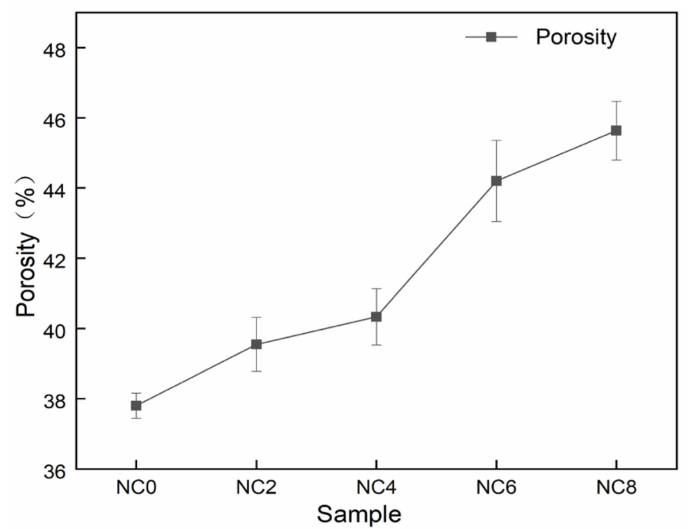
Figure 7. Porosity of PVA/NC nanofiber membranes with different content of